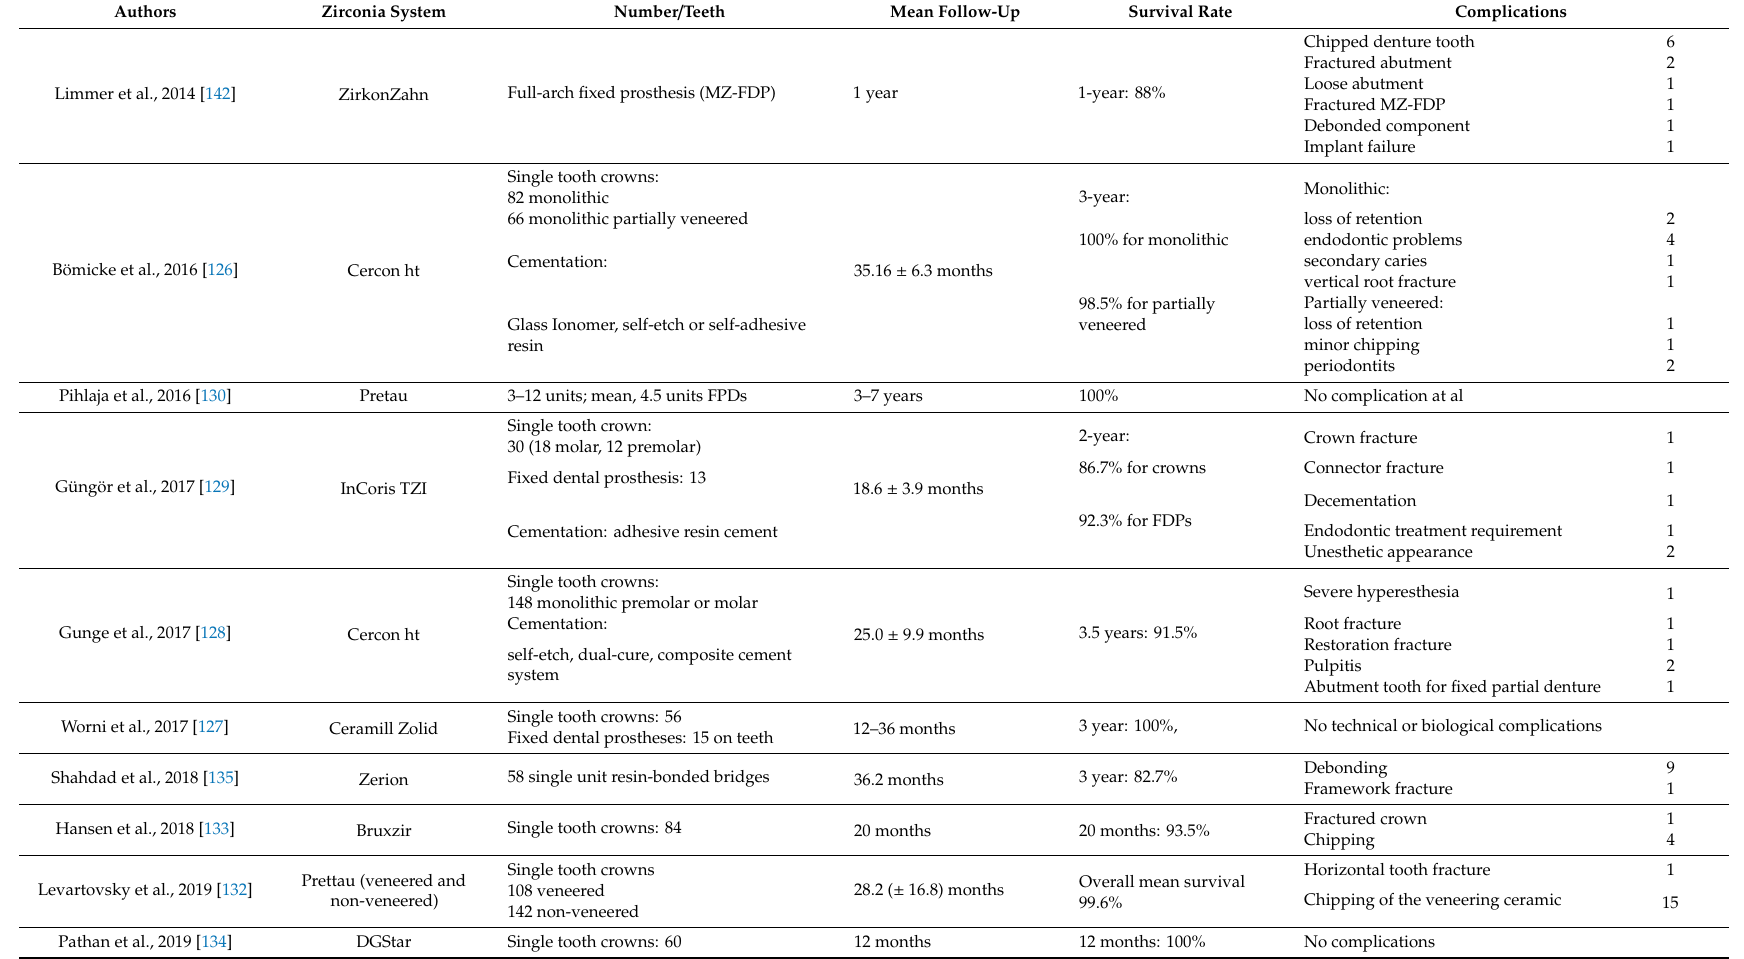
Table 2. Clinical studies with monolithic zirconia restorations on teeth. Studies are presented in ascending chronological